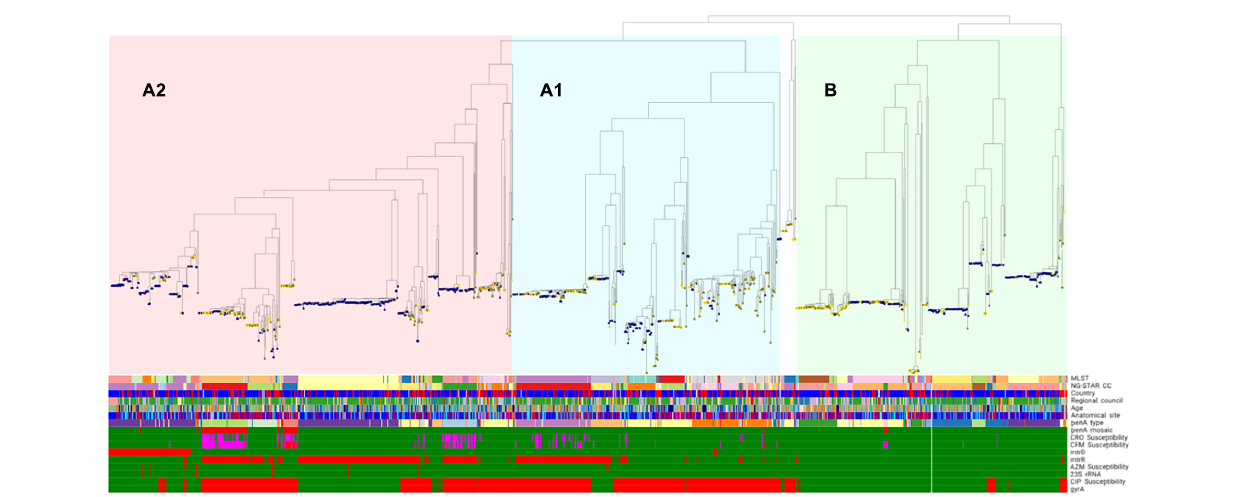
FIGURE 1 | Phylogenomic tree including genomic lineages, molecular typing and phenotypic antimicrobial resistance (AMR) of cultured Neisseria gonorrhoeae isolates ( n = 1278) in Sweden 2016. One isolate was excluded from the phylogeny due to low coverage ( < 70%). Nodes denote sexual orientation (blue, homosexual males; yellow, females; green, heterosexual males; red, bisexual males; white, not reported). Bars for phenotypic antimicrobial susceptibility (or presence/absence of AMR determinants): green, susceptible (or AMR determinant absent); red, resistant (or AMR determinant present); and pink, decreased susceptibility. See line-listed details about the isolates and each determinant, including their color coding, at: https://microreact.org/project/Hadad_et_al_Swe2016. MLST, multi-locus sequence typing; NG-STAR CC, Neisseria gonorrhoeae sequence typing for antimicrobial resistance clonal complex; CFM, cefixime; CRO, ceftriaxone; AZM, azithromycin; CIP,